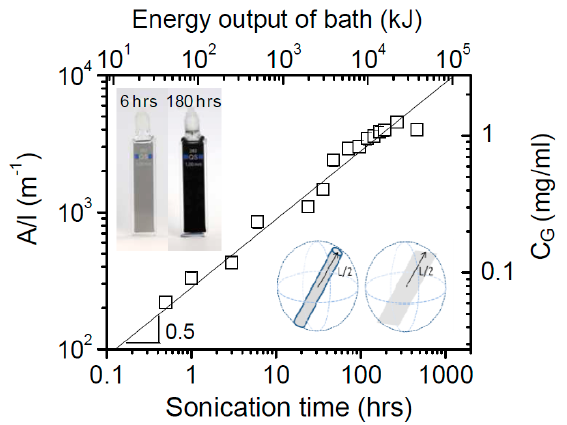
Figure 6. Concentration of graphene in NMP after centrifugation as a function of sonication time. Reproduced from [40]. Copyright Wiley-VCH, 2010.